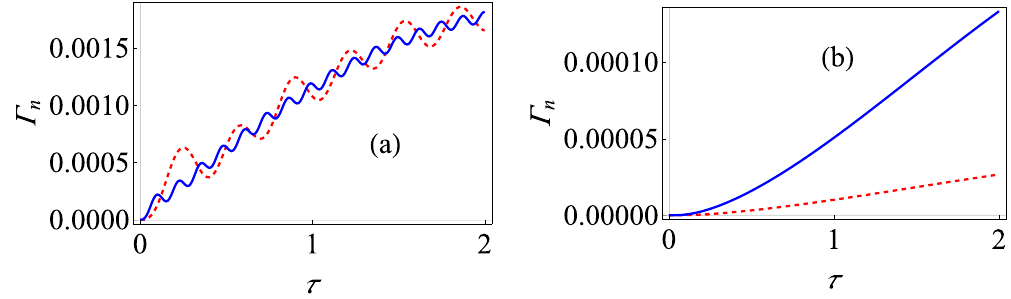
Figure 5. Variation of the effective decay rate τ Γ ( ) for the large spin-boson model. ( a ) Graph of Γ (at zero n temperature) with modification for the strong-coupling regime as a function of τ with j = 1 for the system- environment coupling strength G = 1 (red, dashed curve) and G = 2.5 (solid, blue curve). Here we have used an Ohmic environment ( s = 1), with ε = 1 , ω = 10 , and ∆ = . 0 05 . The initial state is | j 〉 . ( b ) Behaviour of Γ (at c zero temperature) for the usual weak system-environment coupling scenario with ε = 1 and Δ = 0.05 with G = 0.001 (dashed, red curve) and G = 0.005 (solid, blue curve). We have used again an Ohmic environment, the initial state is still | j 〉 and ω = 10 c